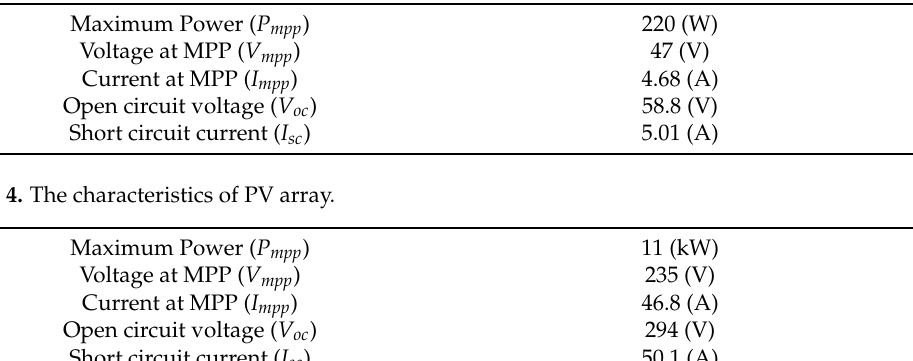
Table 3. The characteristics of Canadian solar CS5P-220M PV module at STC.